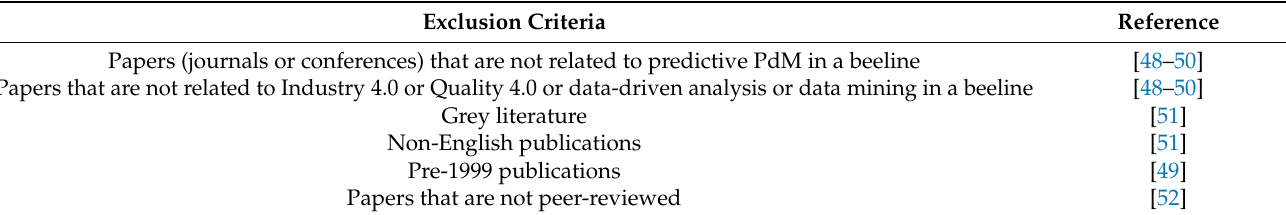
Table 1. Exclusion